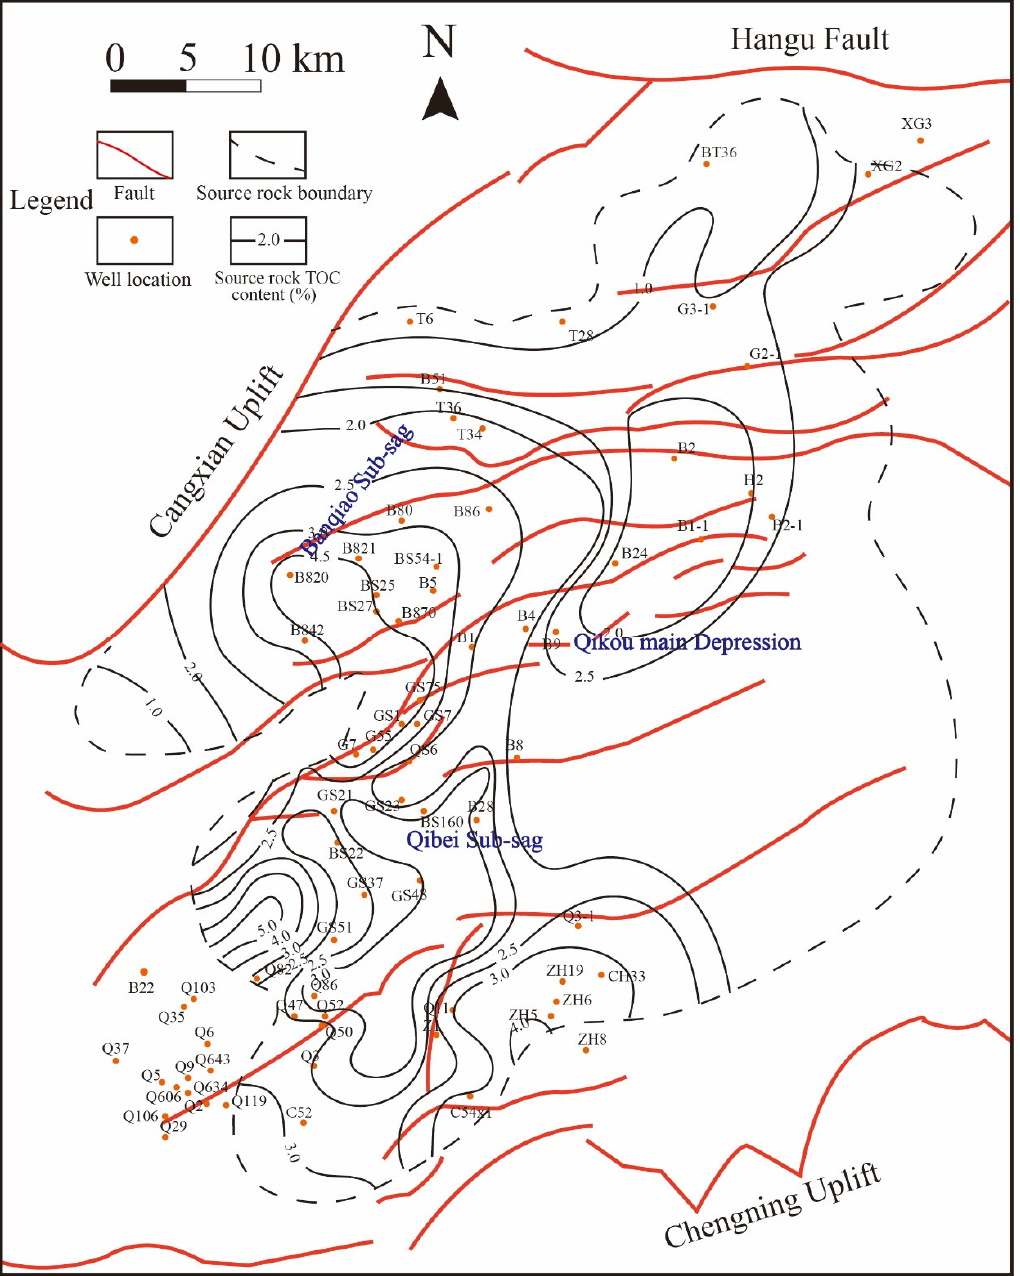
Figure 5. Mbr 3 source rocks’ TOC distribution map.